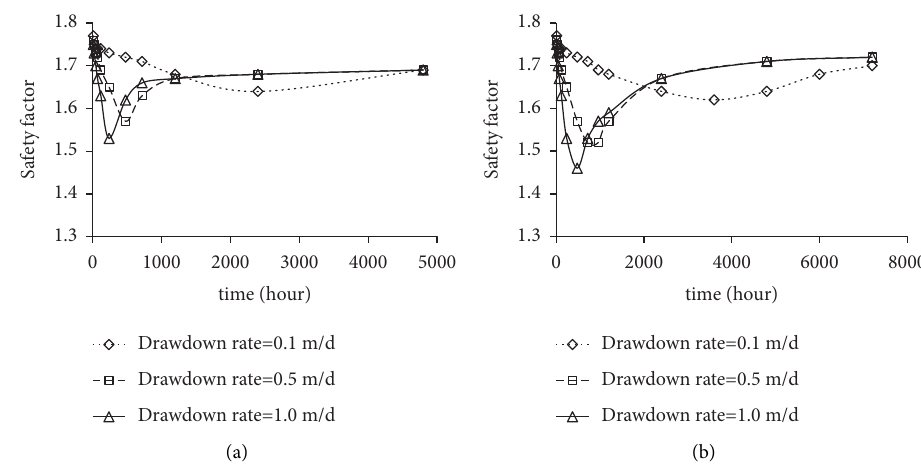
Figure 10: The stability variation versus time in the CCDs (with the same steady safety factors on the upstream slopes): (a) r � 0 . 415 and (b) r � 0 . 830.